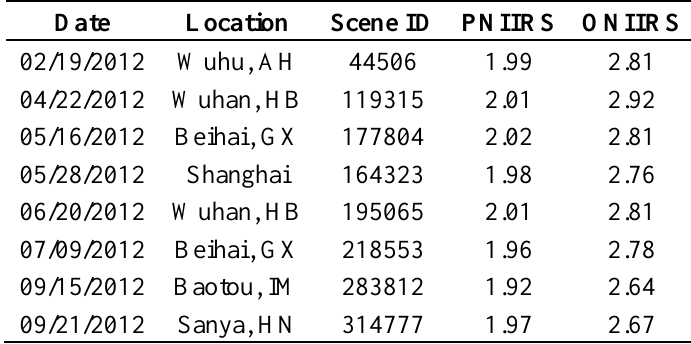
Table 6. Comparison between the ONIIRS and